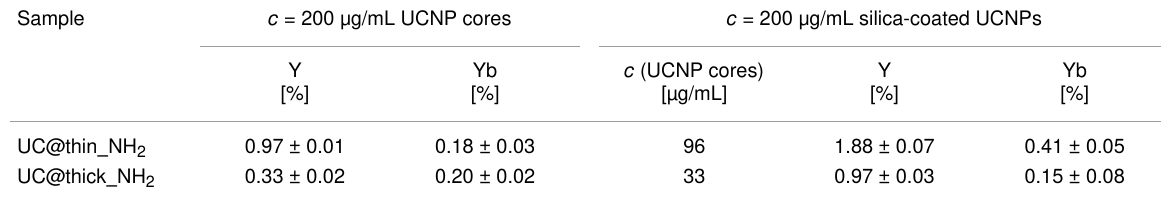
Table 2: Percentages of released lanthanide ions from silica-coated UCNPs obtained via ICP-OES after 24 h of dispersion in water.